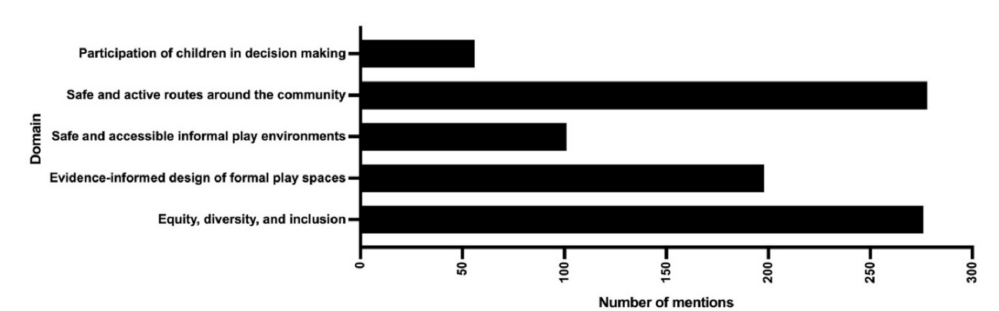
Figure 1. Total number of mentions of indicators in each Play-Friendly Cities domain for Nova Scotia Physical Activity strategies.